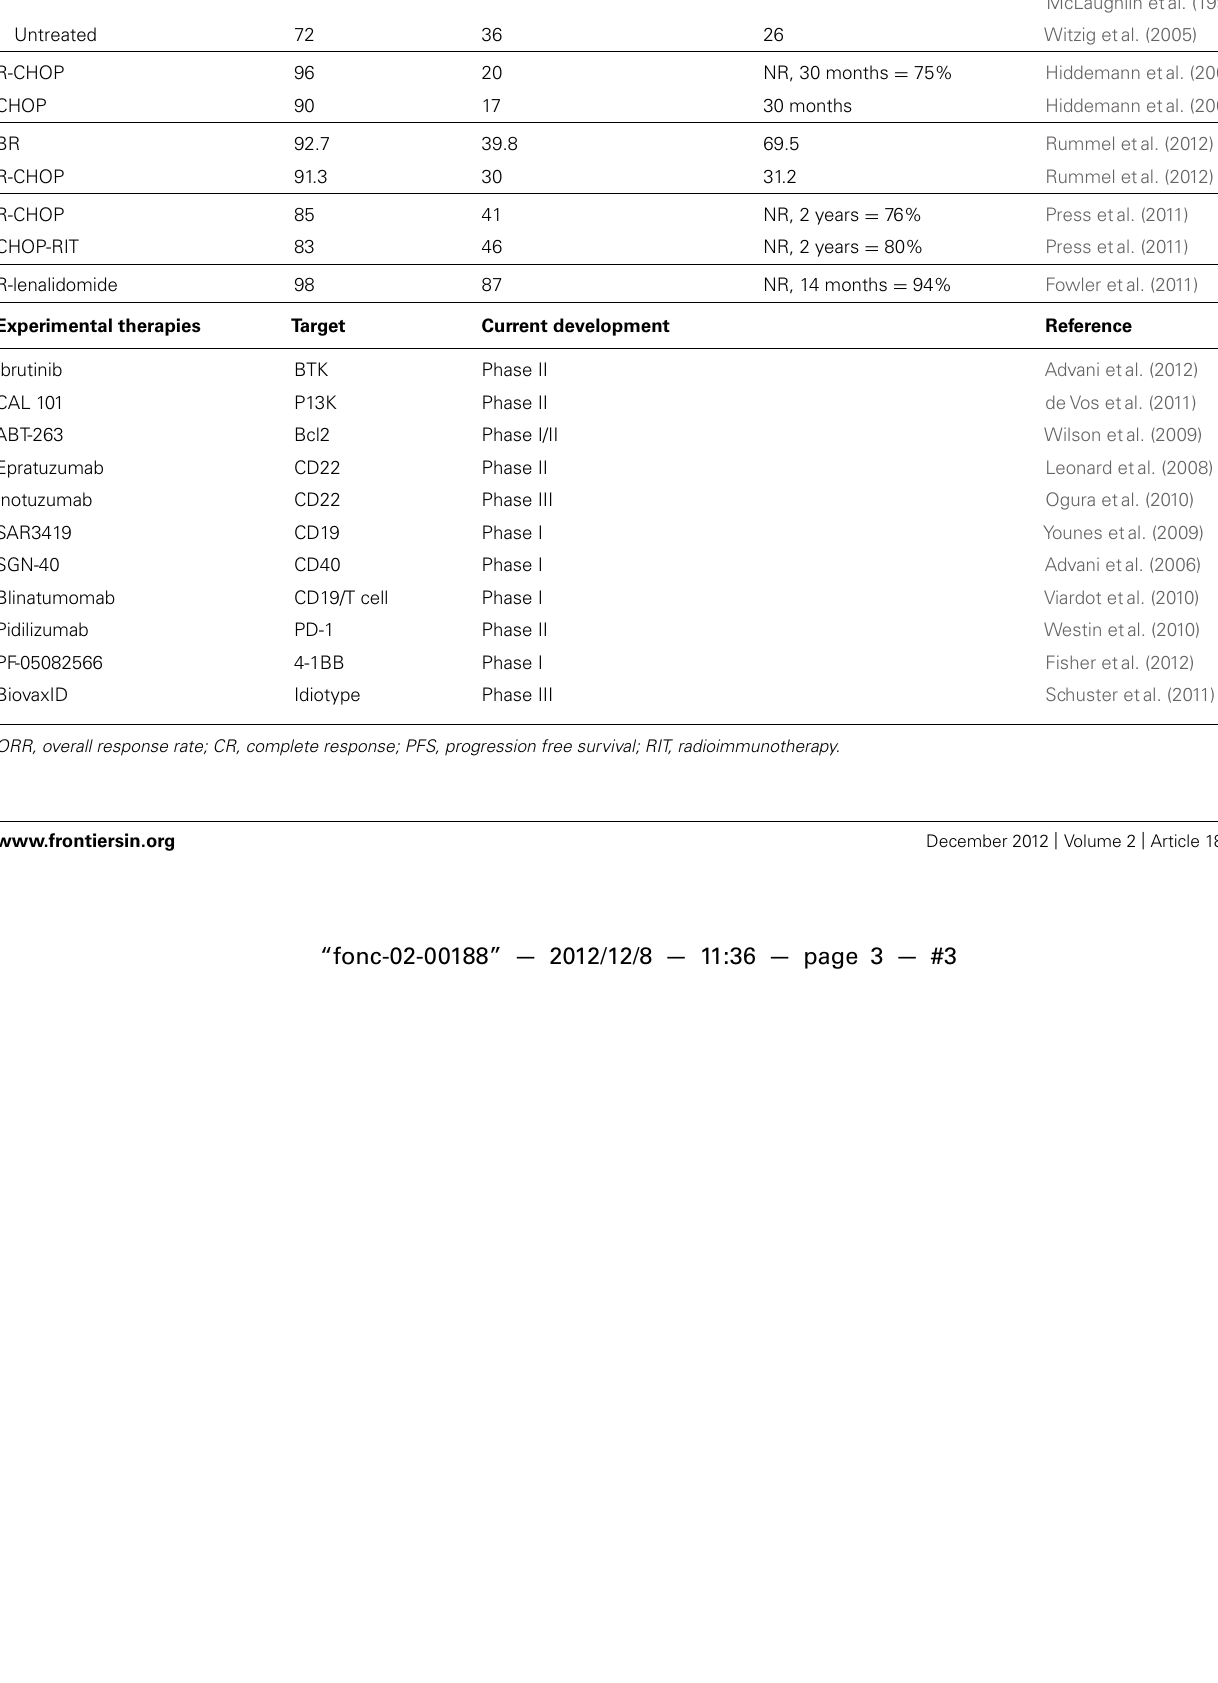
Table 1 | Clinical outcome with various therapeutic regimens in newly diagnosed FL (top) and promising experimental therapies in development in FL (bottom). ORR CR PFS